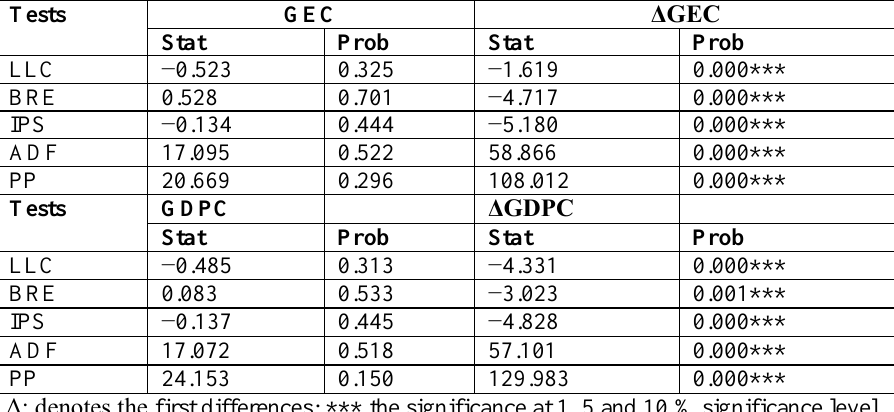
Table 3. Unit Root Test Results